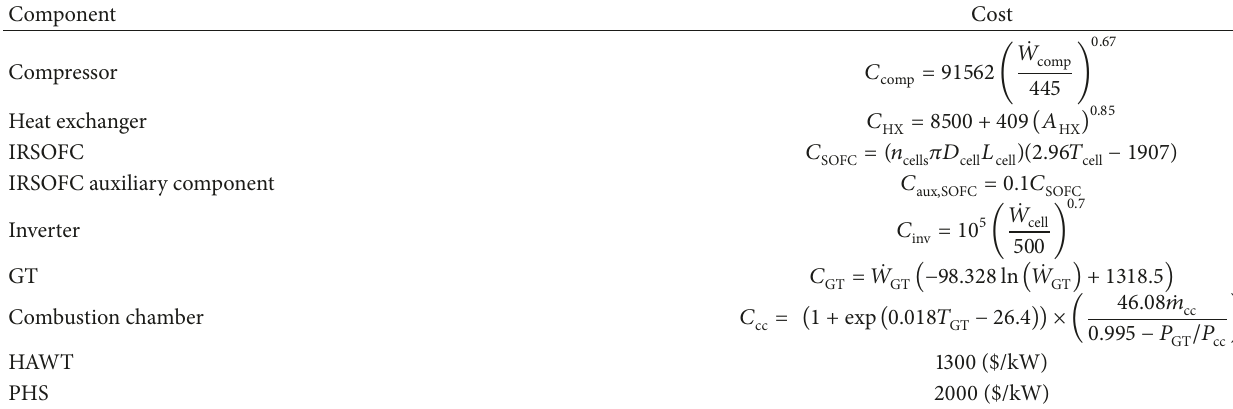
Table 3: Initial capital costs of instruments